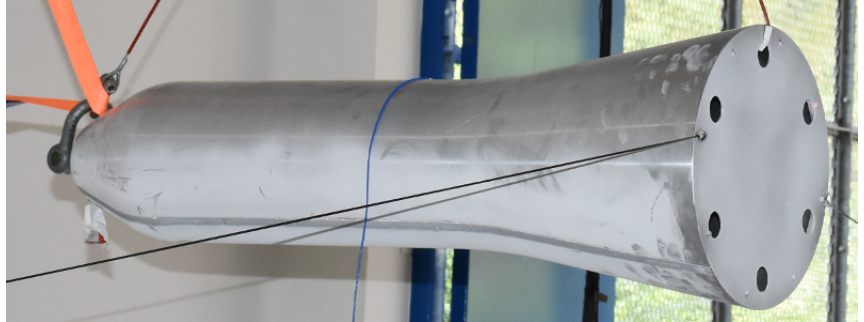
Figure 2. HB–2 structure suspended in the